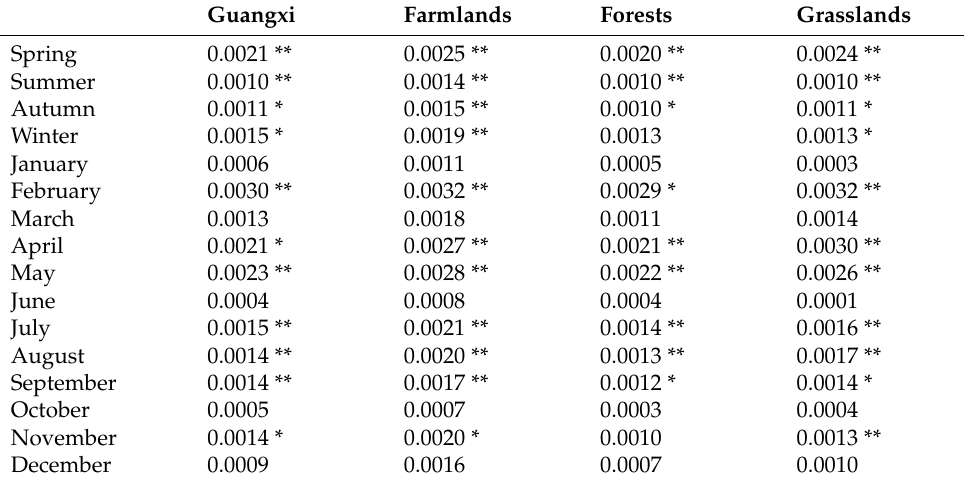
Table 3. Trend rates (unit: year − 1 ) for the seasonal and monthly NDVI during 1982–2015. Guangxi Farmlands Forests Grasslands Spring 0.0021 ** 0.0025 ** 0.0020 ** 0.0024 ** Summer 0.0010 ** 0.0014 ** 0.0010 ** 0.0010 ** Autumn 0.0011 * 0.0015 ** 0.0010 * 0.0011 * Winter 0.0015 * 0.0019 ** 0.0013 0.0013 * January 0.0006 0.0011 0.0005 0.0003 0.0030